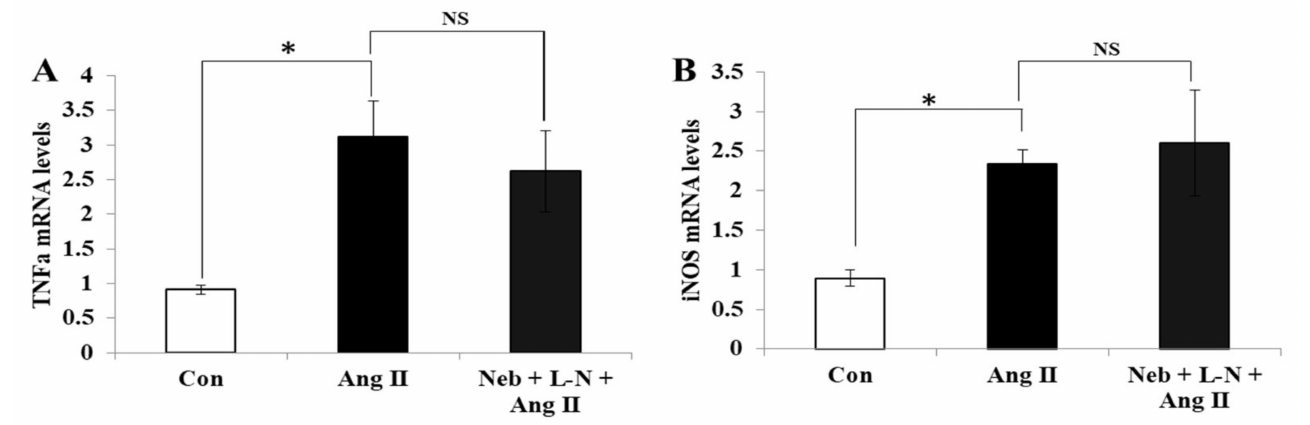
Figure 4. Effects of Neb plus L-N combination on Ang II-induced mRNA expression of proinflam- matory cytokines in H9c2 cardiomyoblasts. mRNA levels of TNF- α ( A ) and iNOS ( B ) were not reduced by Neb + L-N. * p < 0.05 vs. untreated (Con) and NS, nonsignificant vs. Ang II. Values are means ± SEM. N ≥ 3–6 for each treatment